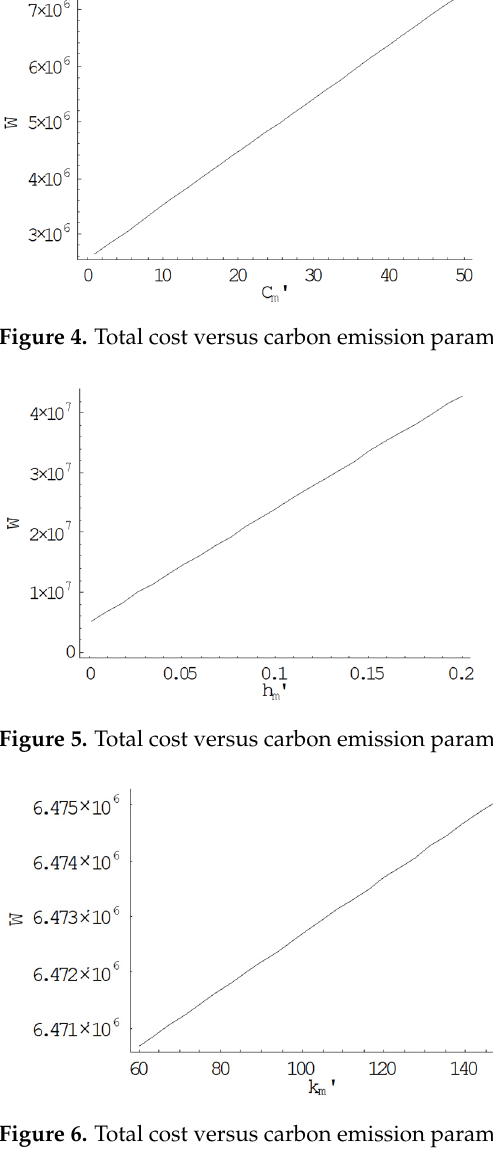
Figure 6. Total cost versus carbon emission parameter k m ’.